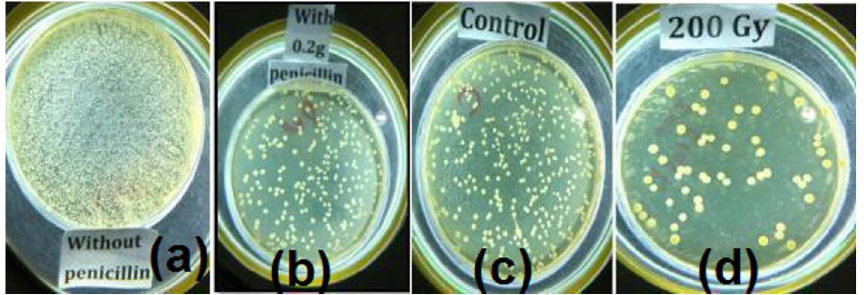
Fig. 4. Characterization of commercial and purified penicillin from P. chrysogenum on S. aureus. (a) Colony count without penicillin. (b) Colony count with commercial penicillin. (c) Colony count with purified penicillin from nonirradiated P. chrysogenum .(d) Colony count with purified penicillin from irradiated P. chrysogenum.